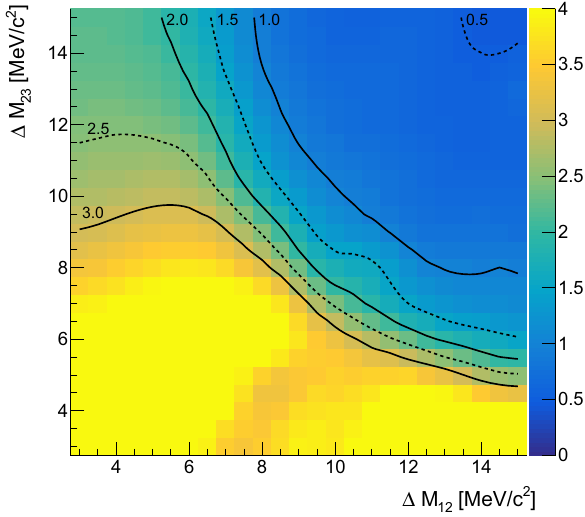
Fig. 6 90% C.L. upper limit on f 3 , as function of the chosen Υ J ( 1 D ) fine splitting values. The black lines represent the curves at fixed values of the UL in steps of 0.5. The corresponding UL value is reported next to each line. Dashed and solid line styles are alternated for